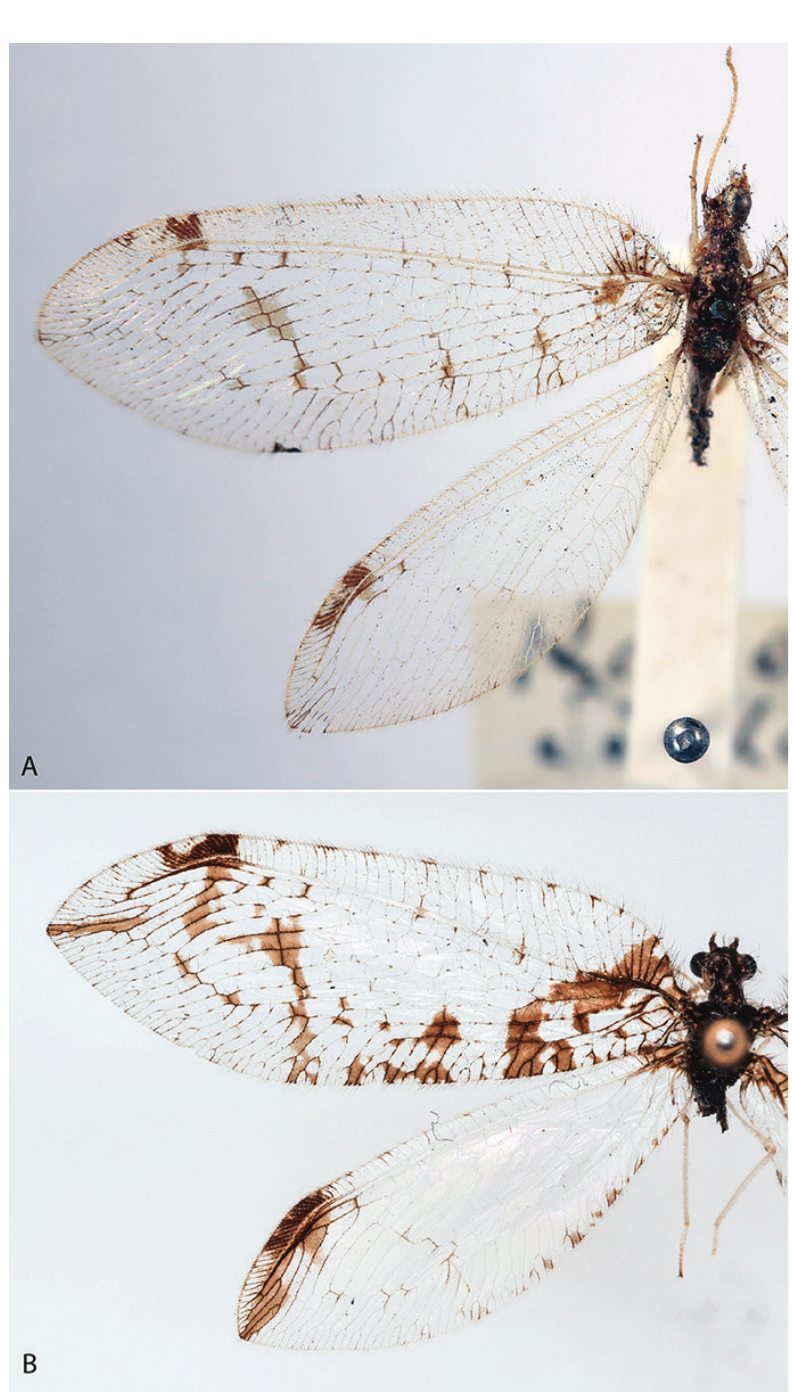
Figure 3. Gryposmylus spp.: A G. pubicosta (Walker) (pale form) (Forewing length 16.5 mm) B G. pennyi sp. n. (Forewing length 16.0